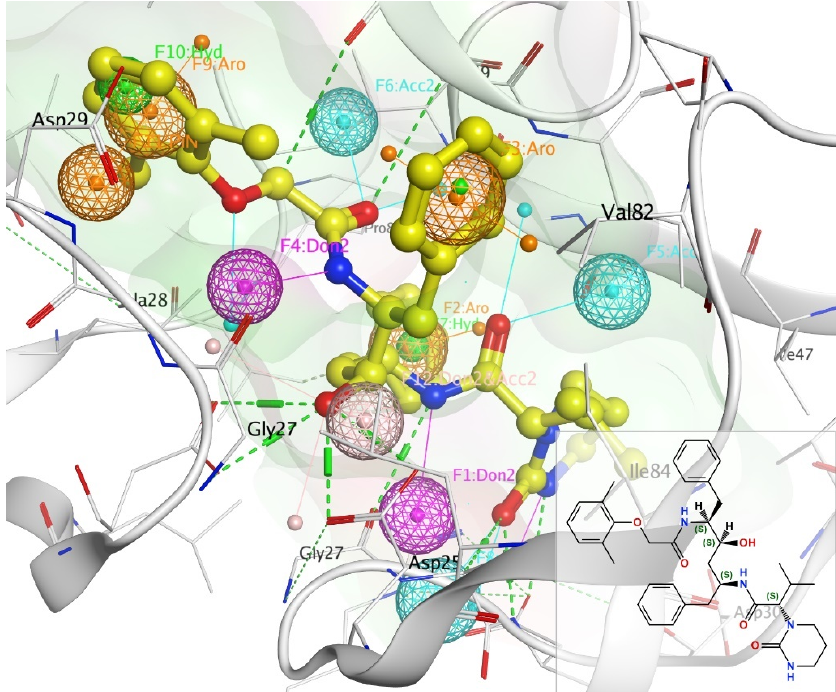
Figure 1. Pharmacophore annotation of lopinavir bound to 2Q5K using unified scheme. Key : H-bond donor—Don (pink), H-bond acceptor—Acc (cyan), hydrophobic atom—HydA (green), projected donor—Don2 (pink), projected acceptor—Acc2 (cyan), aromatic—Aro (orange).